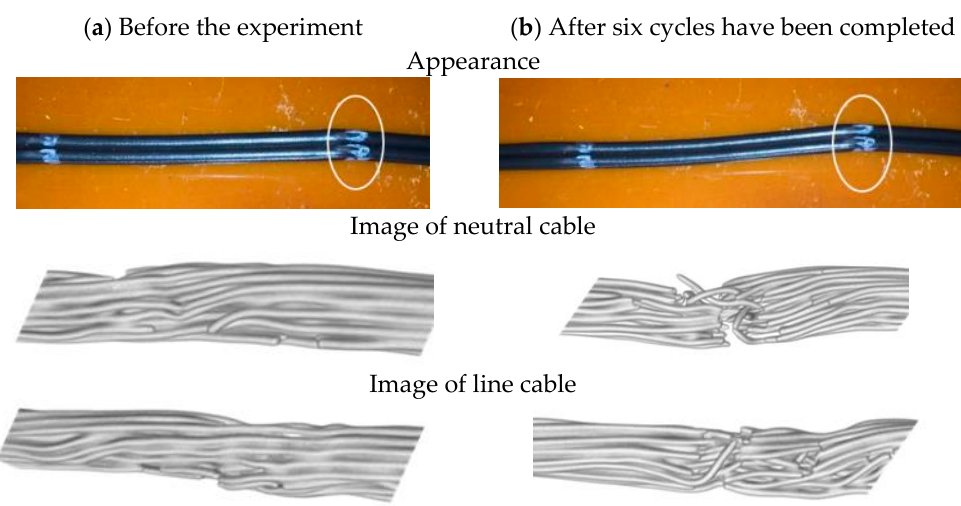
Figure 7. Appearance of partially broken power supply cords and images of element conductors in cords obtained with the microfocus X-ray CT system.